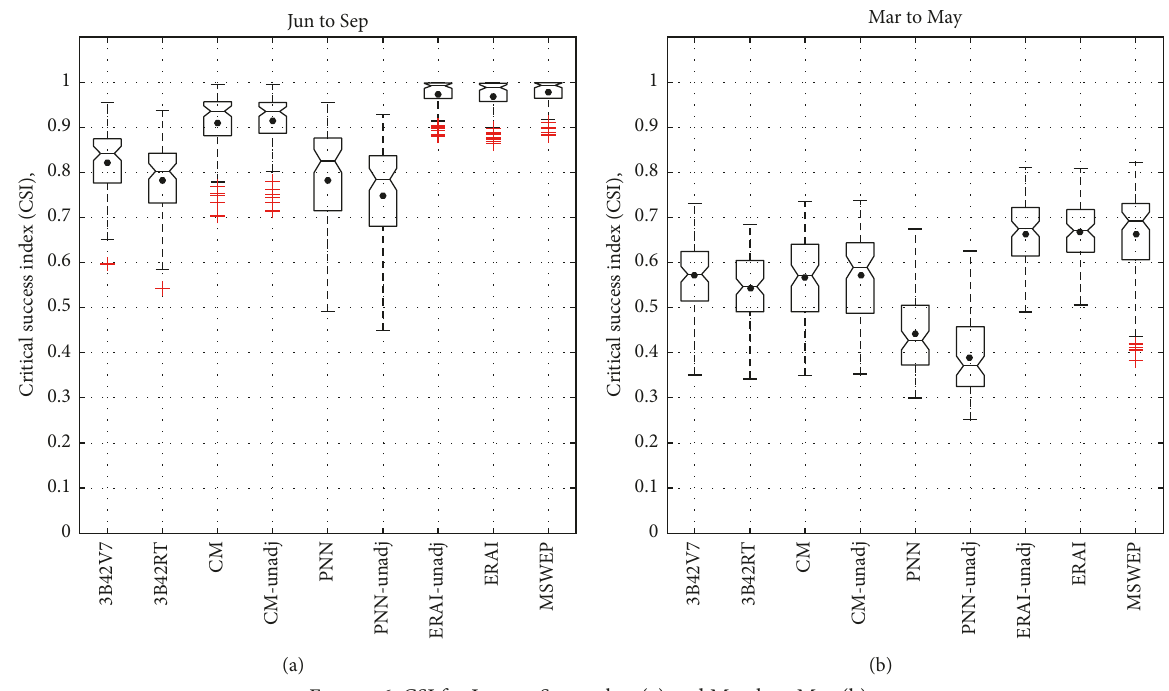
Figure 6: CSI for June to September (a) and March to May